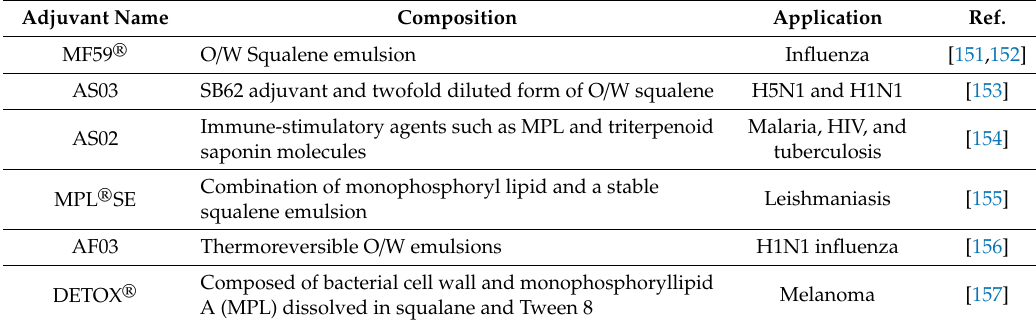
Table 8. List of NEs as